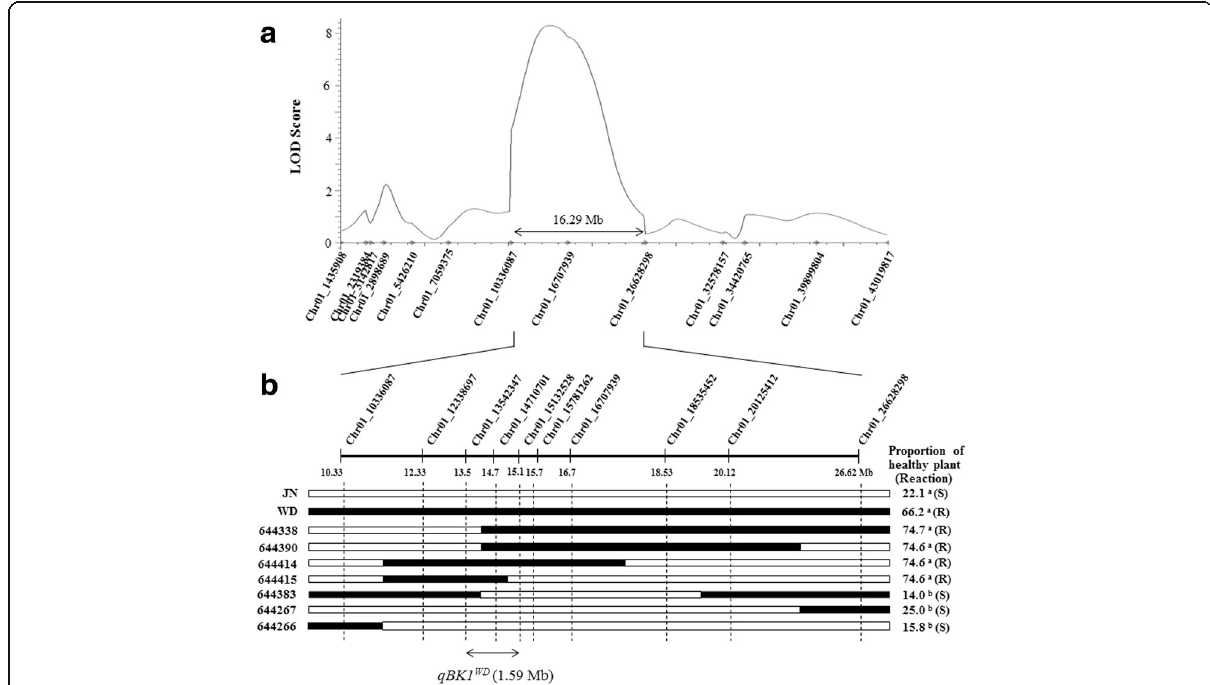
Fig. 4 Quantitative trait locus (QTL) analysis of qBK1 WD using recombinant inbred lines (RILs) derived from a cross between Wonseadaesoo and Junam rice plants. a In primary mapping, qBK1 WD was identified in a 16.29 Mb region between the InDel markers chr01_10336087 and chr01_26628298 on chromosome 11. b Location of qBK1 WD was narrowed down to 1.59 Mb by finer mapping using homozygous recombinants. The proportion of healthy plant were calculated from biological replications. Values (%) of the proportion of healthy plant with different letters are significantly different by Duncan ’ s multiple range test at P =